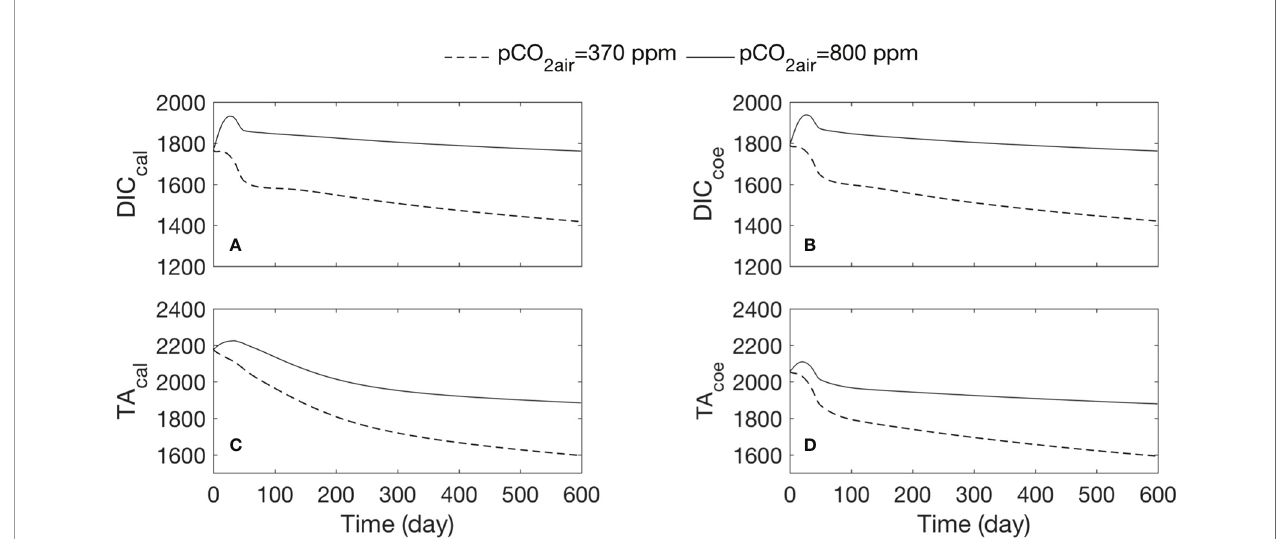
FIGURE 8 | Comparison of DIC and TA change under different air p CO 2 conditions. Dashed lines show the results of the coupled run with air p CO 2 at 340 ppm; black lines demonstrate the results of the coupled run with air p CO 2 at 800 ppm. We show the results for the mean of every 24 h. (A) Time series of DIC in the calcifying fl uid, (B) DIC in the coelenteron, (C) TA in the calcifying fl uid, (D) TA in the